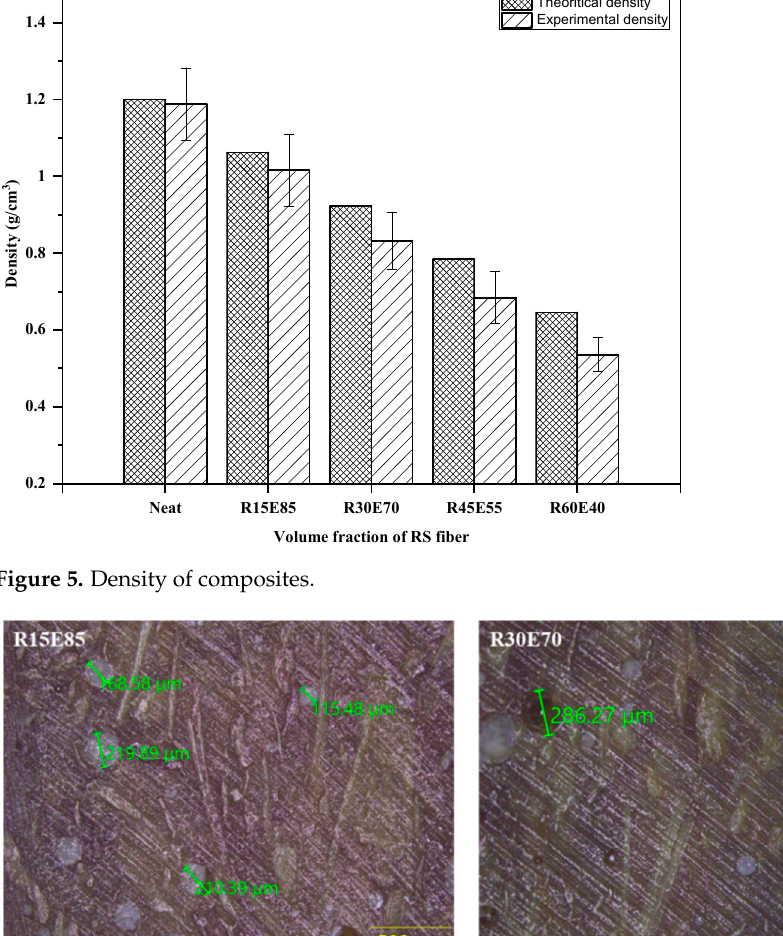
Figure 7. Vickers hardness of test samples.